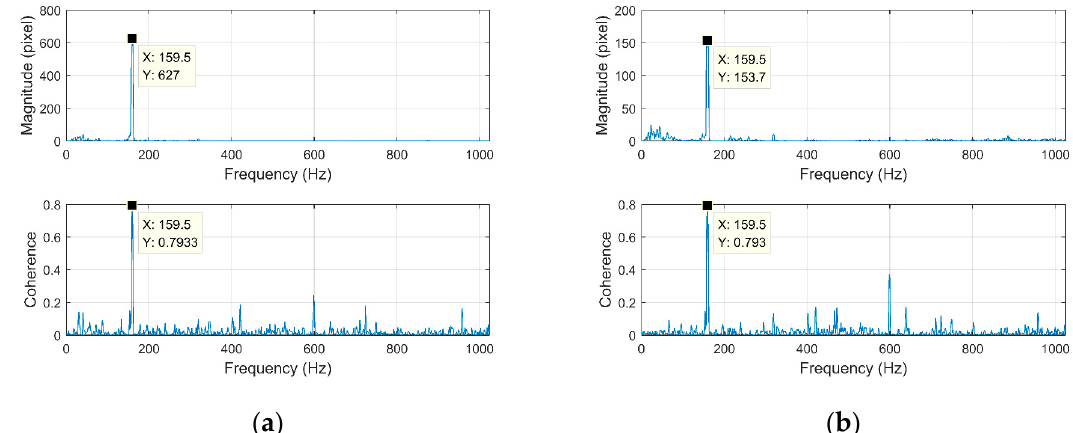
Figure 11. The FRF and coherence at 600 rpm. ( a ) H 16 ; ( b ) H 26 .